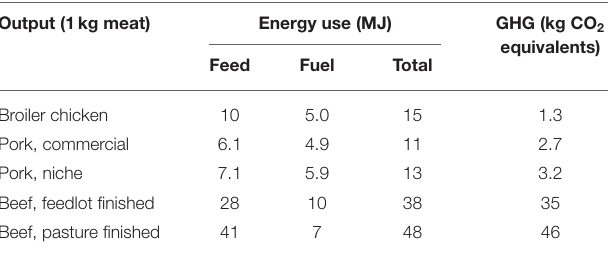
TABLE 3 | Life cycle analysis of energy inputs and emissions of greenhouse gases (GHG, measured as CO 2 equivalents) in the production of 1kg of meat in broiler chicken, pork, and beef production systems (after Pelletier, 2008; Pelletier et al.,